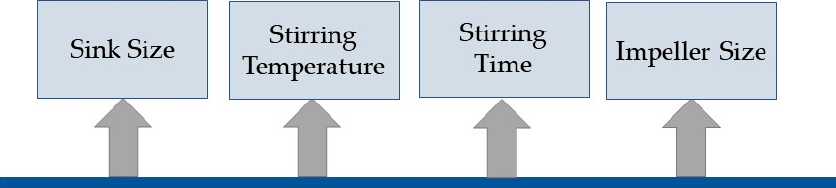
Figure 5. Stir casting setup.